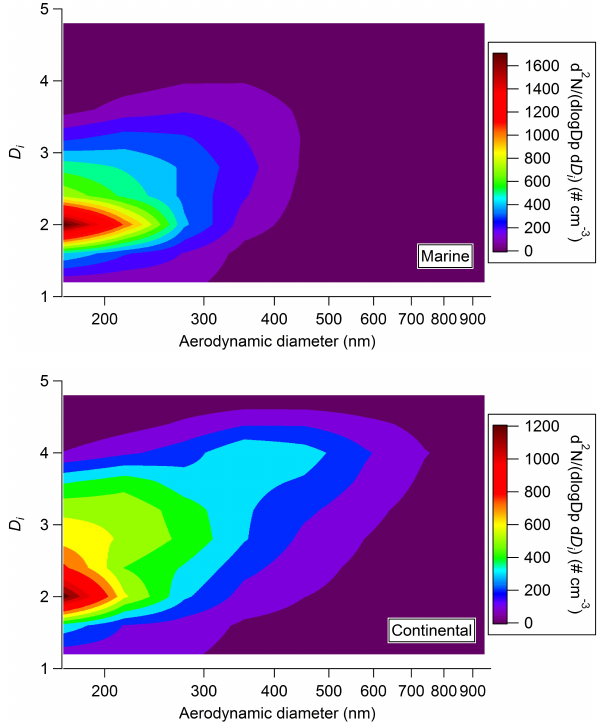
Figure 9. Average dependence of particle number concentration on ATOFMS-derived single particle diversity ( D i ) and particle diame- ter for periods influenced by marine (top) and continental air masses